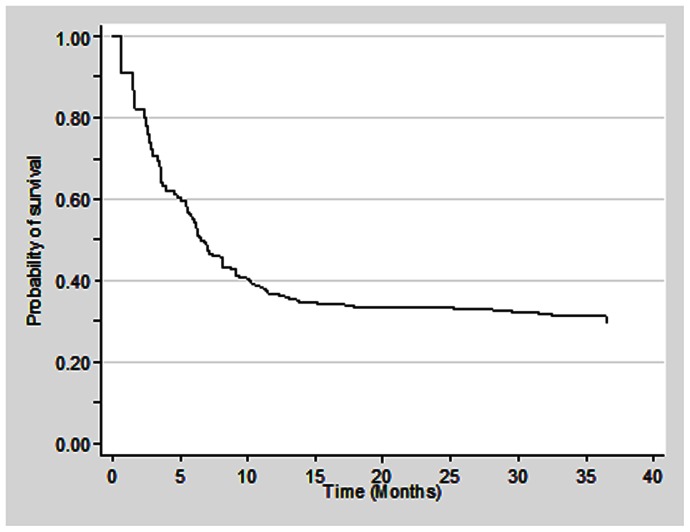
Kaplan Meier survival estimates among HIV infected individuals who were on ART (N = 239).